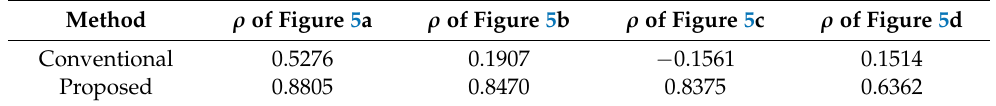
Table 6. Correlation analysis of respiratory rate extracted from 4